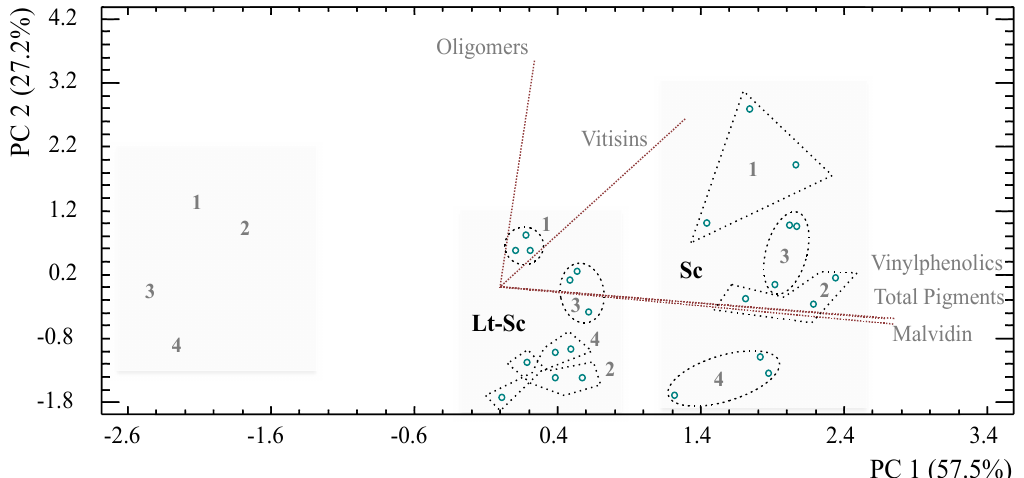
Table 5. Results from UV-Vis determination of colour parameters and polyphenols. The statistical analysis is given by parameter (columns) and the difference in letters indicates significant statistical difference (LSD method with 95% confidence level). Means ± STD ( n = 3).